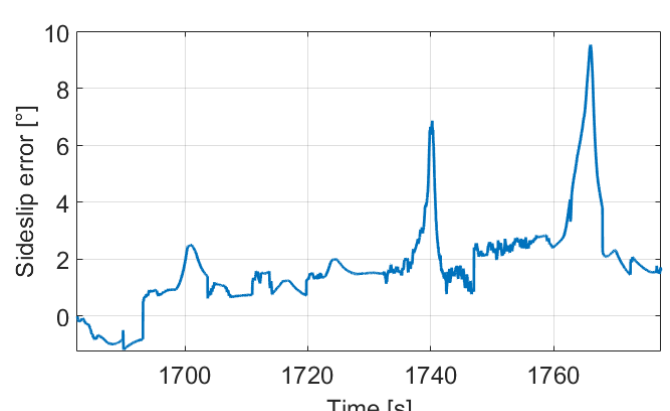
Figure 10. Deviation of the methods.